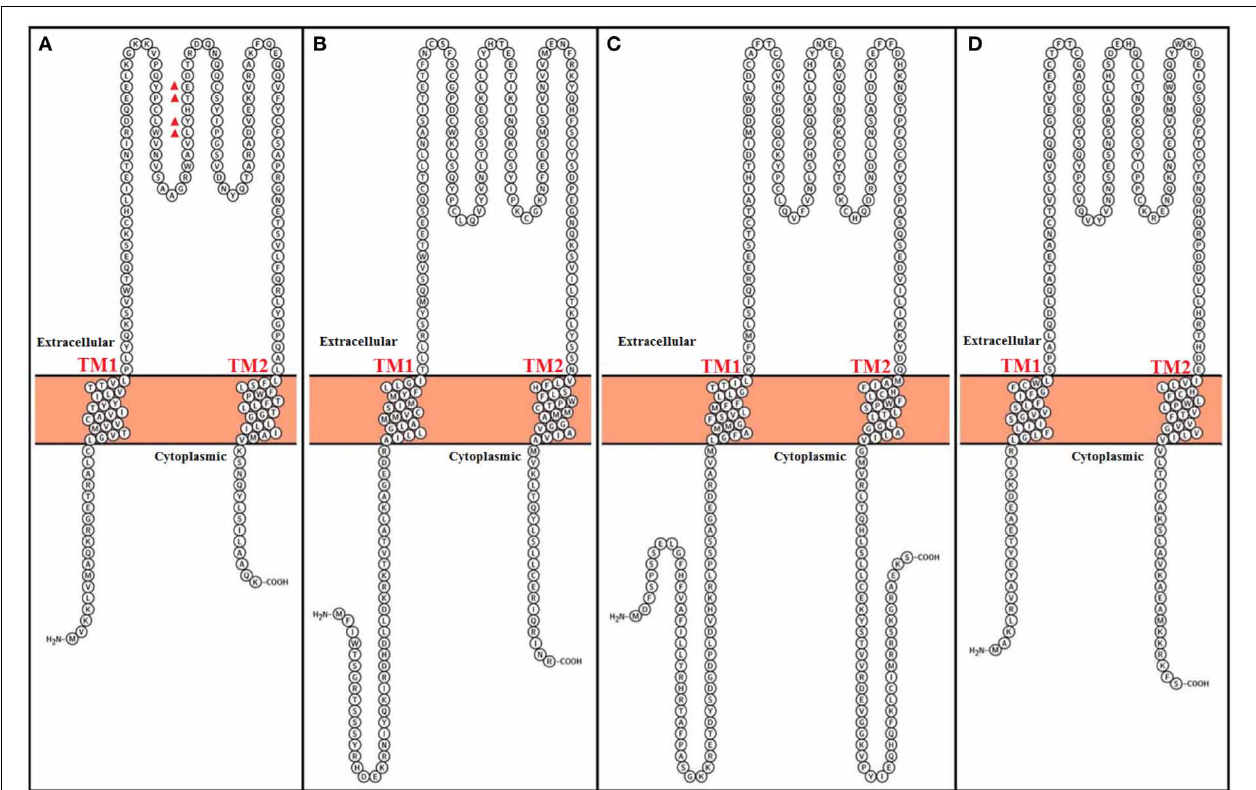
FIGURE 3 | Topological representation of human Calcium-activated potassium channel β subunits. Using Protter visualizator (Omasits et al., 2014). UniProt protein accession: (A) KCMB1: Q16558, (B) KCMB2: Q9Y691, (C) KCMB3: Q9NPA1, (D) KCMB4: Q86W47.